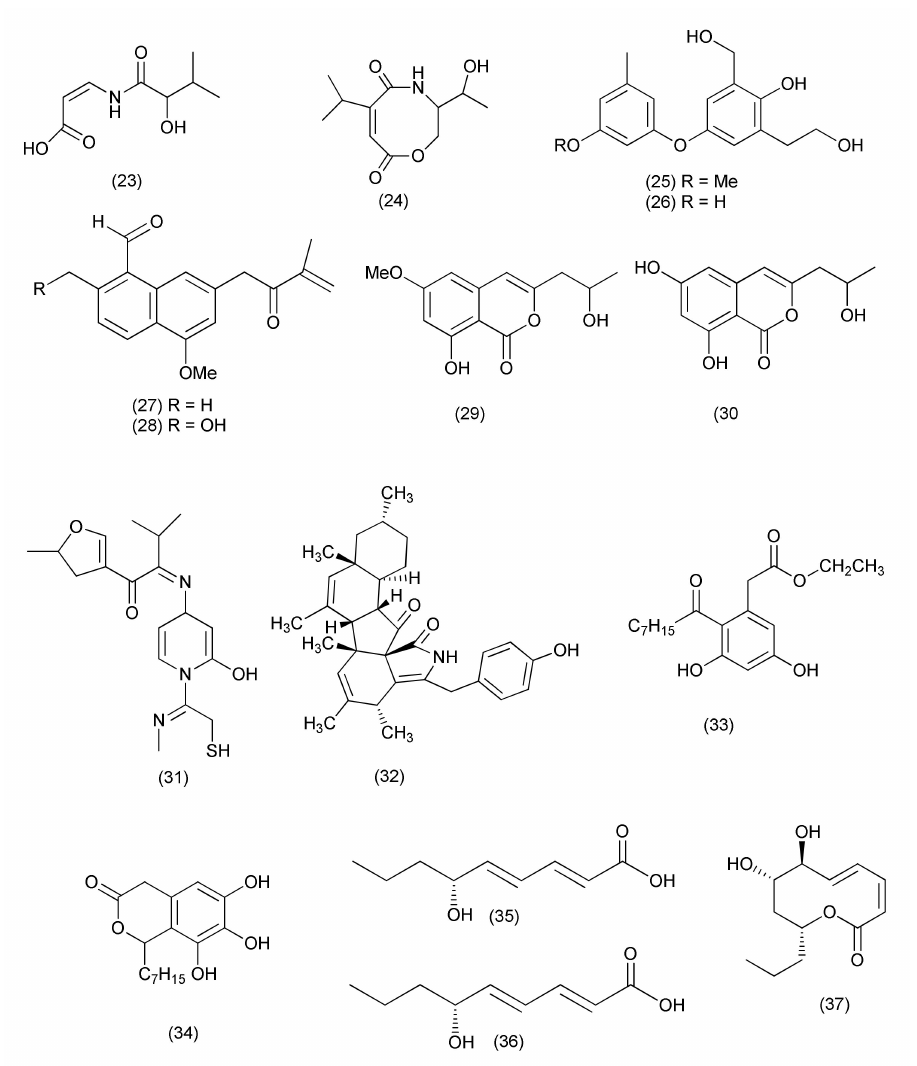
Figure 2. Structures of metabolites 23 – 37 isolated from